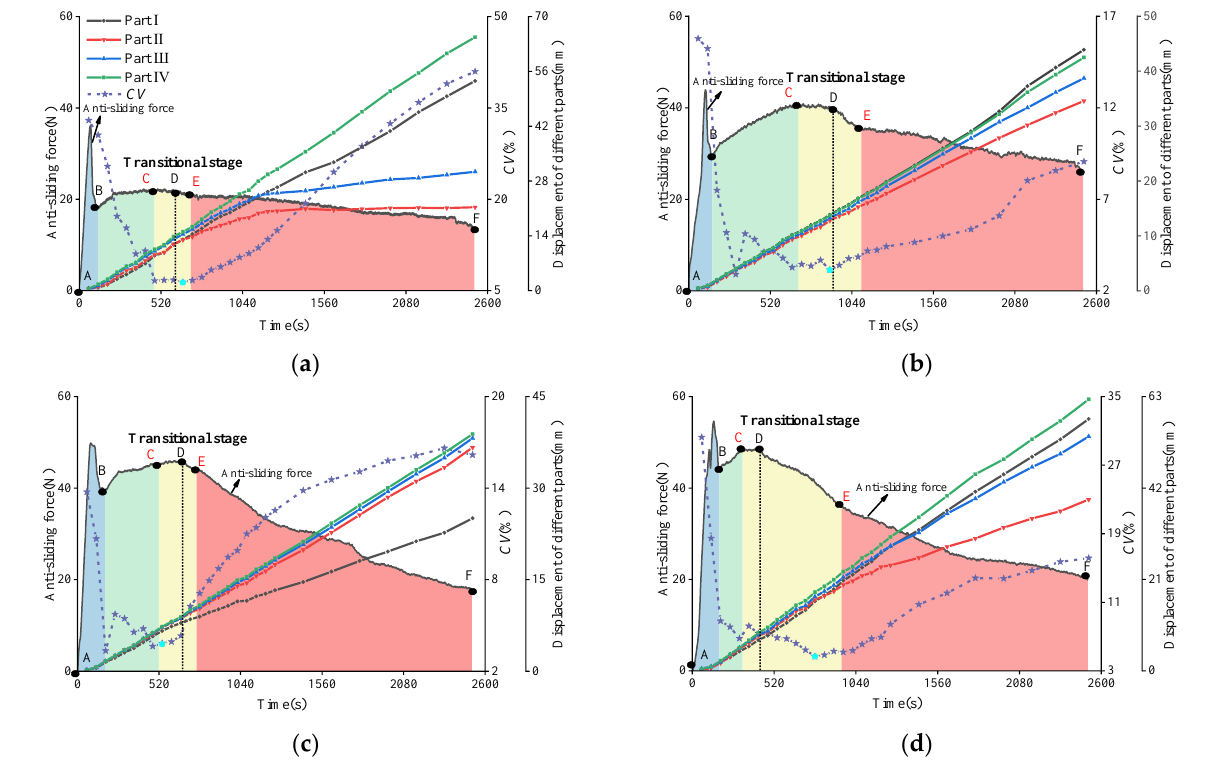
Figure 15. Synergistic evolution law of anti-sliding force and displacement of different parts. ( a ) condition 1, ( b ) condition 2, ( c ) condition 3, ( d ) condition 4.